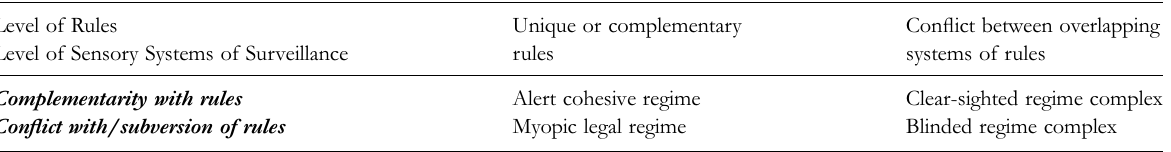
Table 1: Four Types of Transnational Legal Regimes Level of